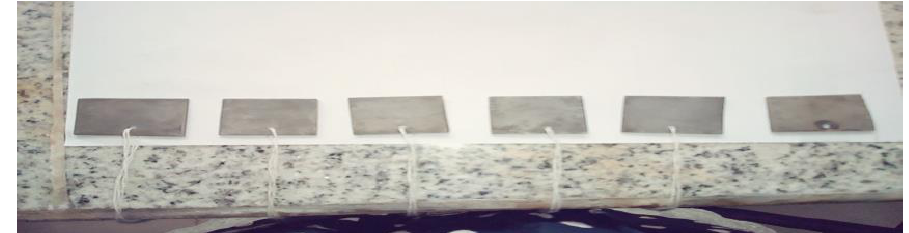
Figure 3: Cleaned specimen after corrosion